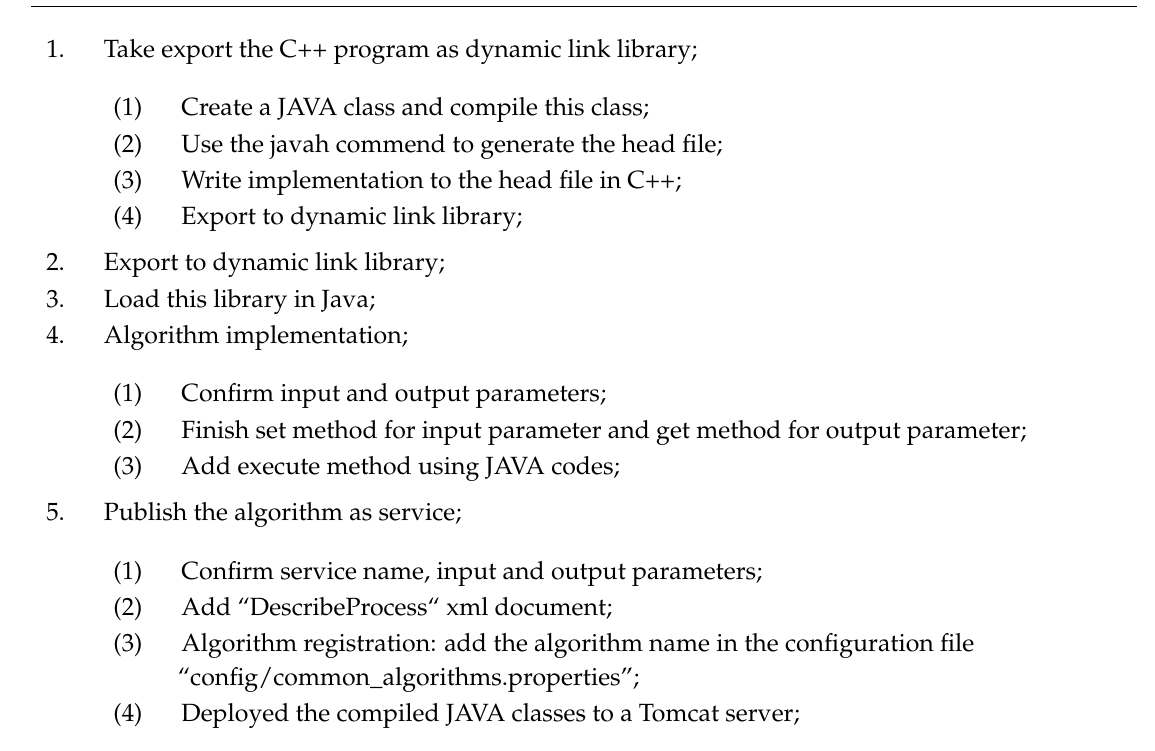
Algorithm registration: add the algorithm name in the configuration file Deployed the compiled JAVA classes to a Tomcat